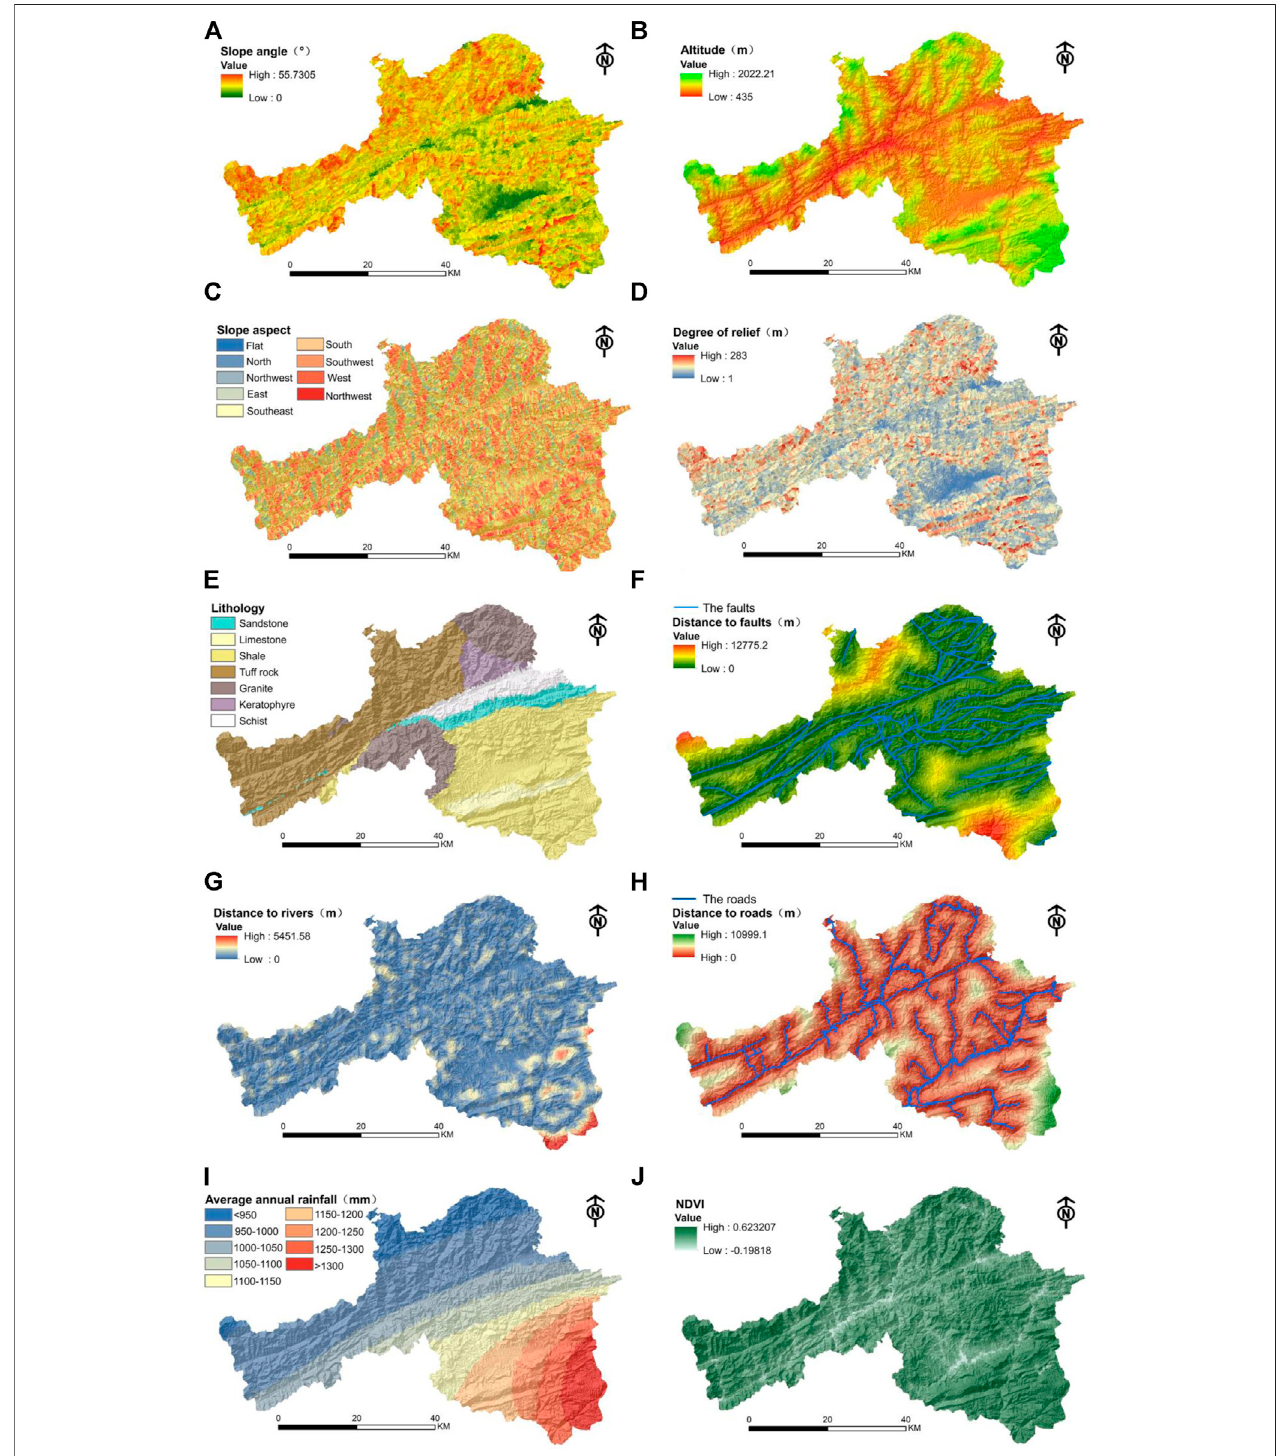
FIGURE 4 | Conditioning factor maps based on slope units. (A) slope-angle, (B) altitude, (C) slope-aspect, (D) degree of relief, (E) lithology, (F) distance to faults, (G) distance to rivers, (H) distance to roads, (I) annual average rainfall, (J) Normalized difference vegetation index (NDVI).